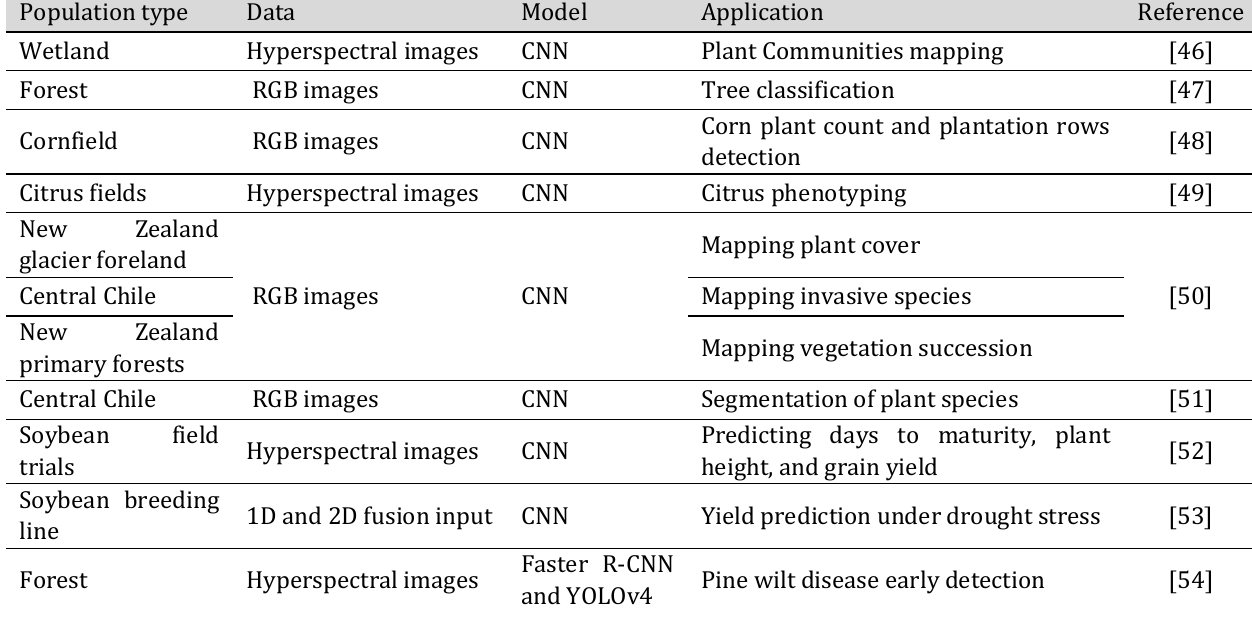
Table 3. Recent deep learning applications in plant population studies.